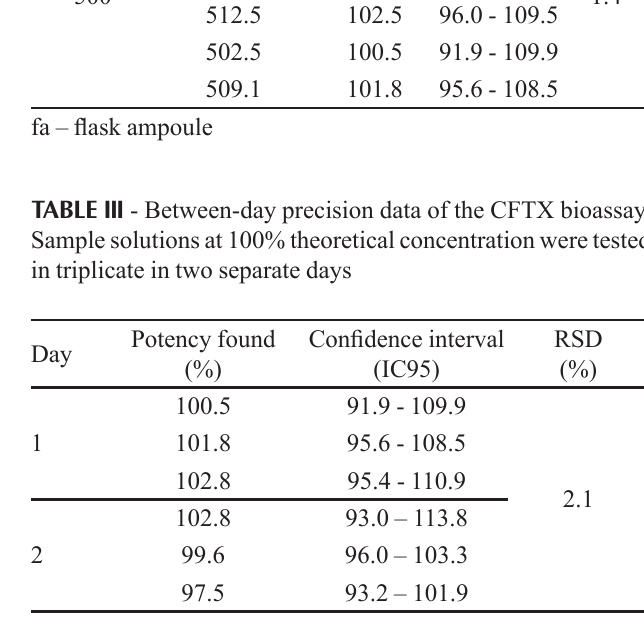
TABLE IV - Between-analyst precision results obtained in the CFTX bioassay validation. Sample solutions at 100% theoretical